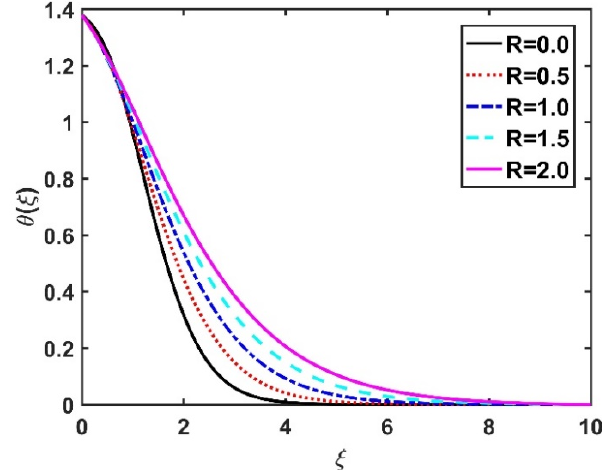
Figure 10. Impact of 𝐸𝑐 on 𝜃(cid:4666)𝜉(cid:4667) .